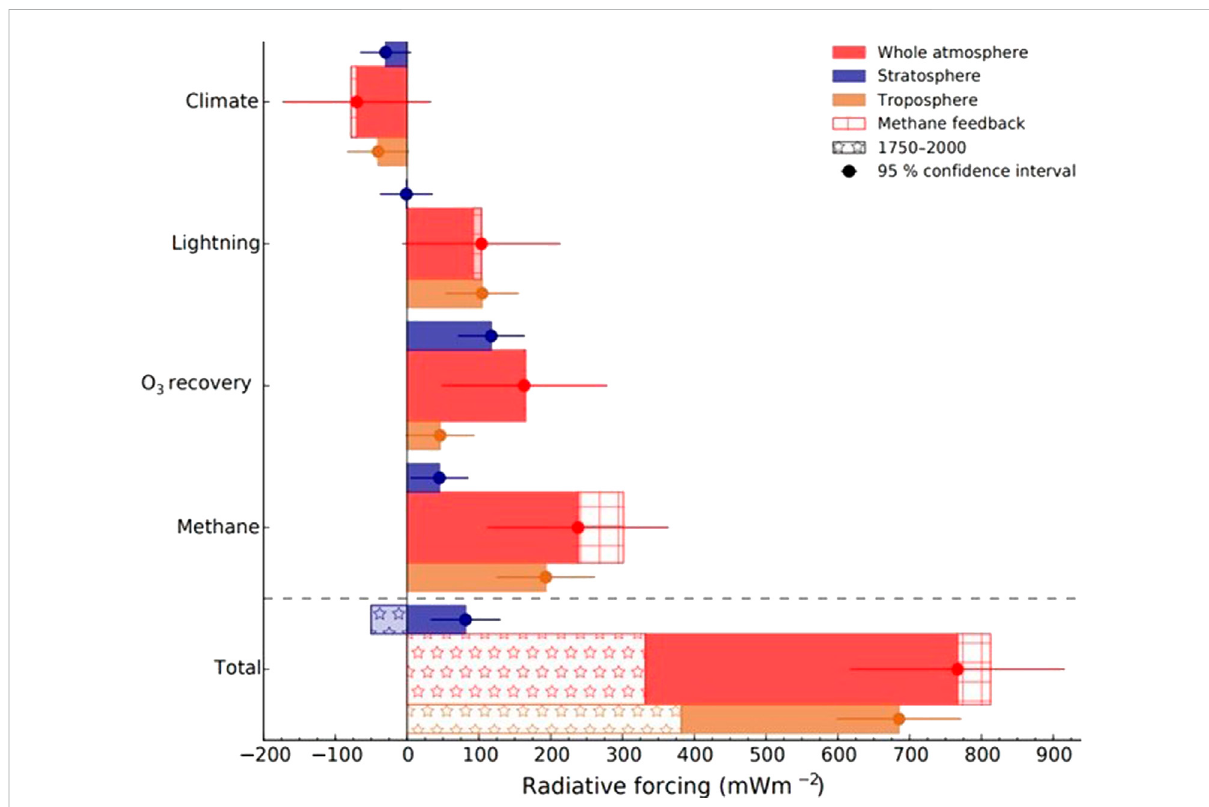
FIGURE 5 Ozoneradiativeforcingsbydrivers2000 – 2,100 mW/m 2 byIglesias-Suarezetal.(2018)islicensedunderCCBY-ND4.0.Tropospheric(brown), stratospheric (blue), and net (whole atmosphere, red) forcings are shown. Associated ozone forcings with methane feedback (square hatched) are shownalongwiththenetforcings.Theoverallozoneforcing(total)isthesumoftheindividualforcings(climate,lightning,O 3 recovery,andmethane scaled to 1750 (star hatched). Dots and error bars indicate the mean and the 95% con fi dence intervals of the forcings,